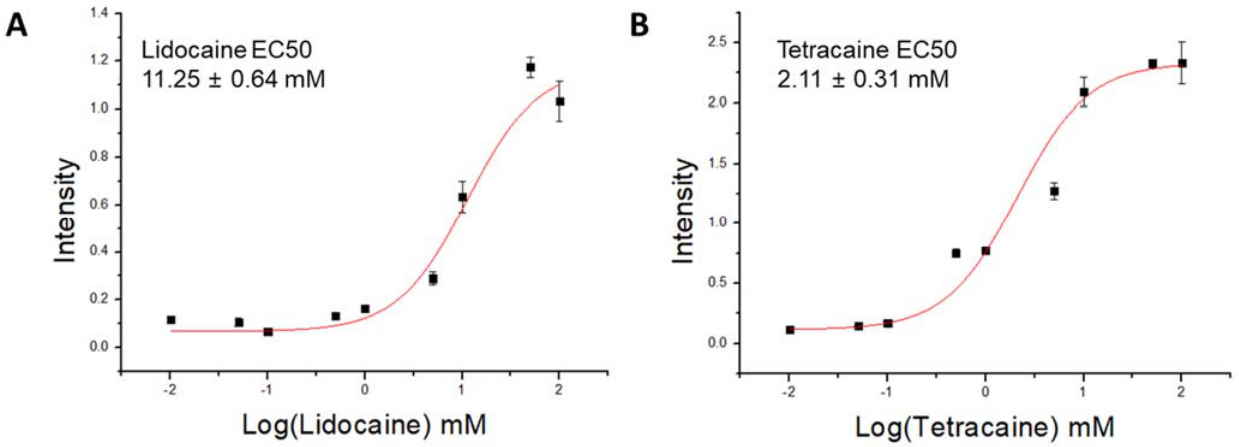
Figure 5. Concentration response curve to calculate EC50 ( A ) The lidocaine EC50 is 11.25 mM ( B ) The tetracaine EC50 is 2.11 mM. (n = 3, p < 0.001).